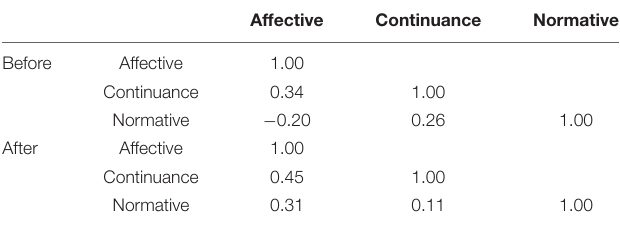
TABLE 7 | Pearson’s R correlation test